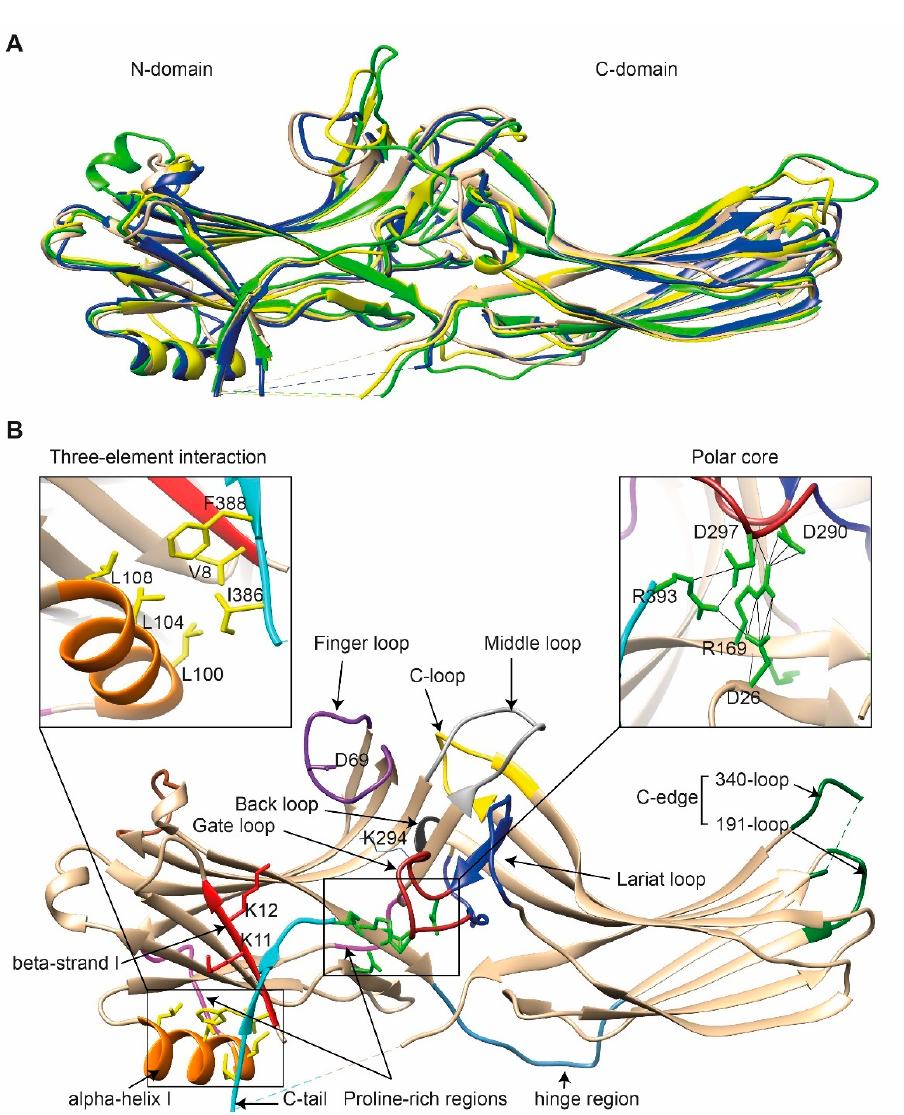
Figure 1. The basal structures of arrestins. ( A ) The crystal structures of bovine arrestin-1 (PDB: 1CF1, green [16]), bovine arrestin-2 (PDB: 1G4M, tan [17]), bovine arrestin-3 (PDB: 3P2D, blue [26]), and tiger salamander arrestin-4 (PDB: 1SUJ, yellow [20]) in the basal state are superimposed. Parts that are not resolved in the crystal structures are indicated by dashed lines. ( B ) Crystal structure of arrestin-2 (PDB: 1G4M [17]) in the basal state. Functionally important loops and critical residues are indicated and highlighted as follows: finger loop, purple; inter-domain hinge, blue-gray; β -strand I and the two lysines in it, red; α -helix I, orange; C-tail, light blue; hydrophobic side chains of residues in the α -helix, β -strand I, and β -strand XX of the C-tail mediating the three-element interaction, yellow; charged side chains of the five residues forming the polar core, green; polyproline motifs, light magenta; lariat loop, dark blue; its part called the gate loop, dark red; C-loop, yellow; back loop, black; C ‐ edge loops, dark green. The side chain of the K294 in the gate loop pointing to the cavity of the N ‐ domain is also shown. Close ‐ up views of the three ‐ element interaction and the polar core are shown in the left and right inserts, respectively.